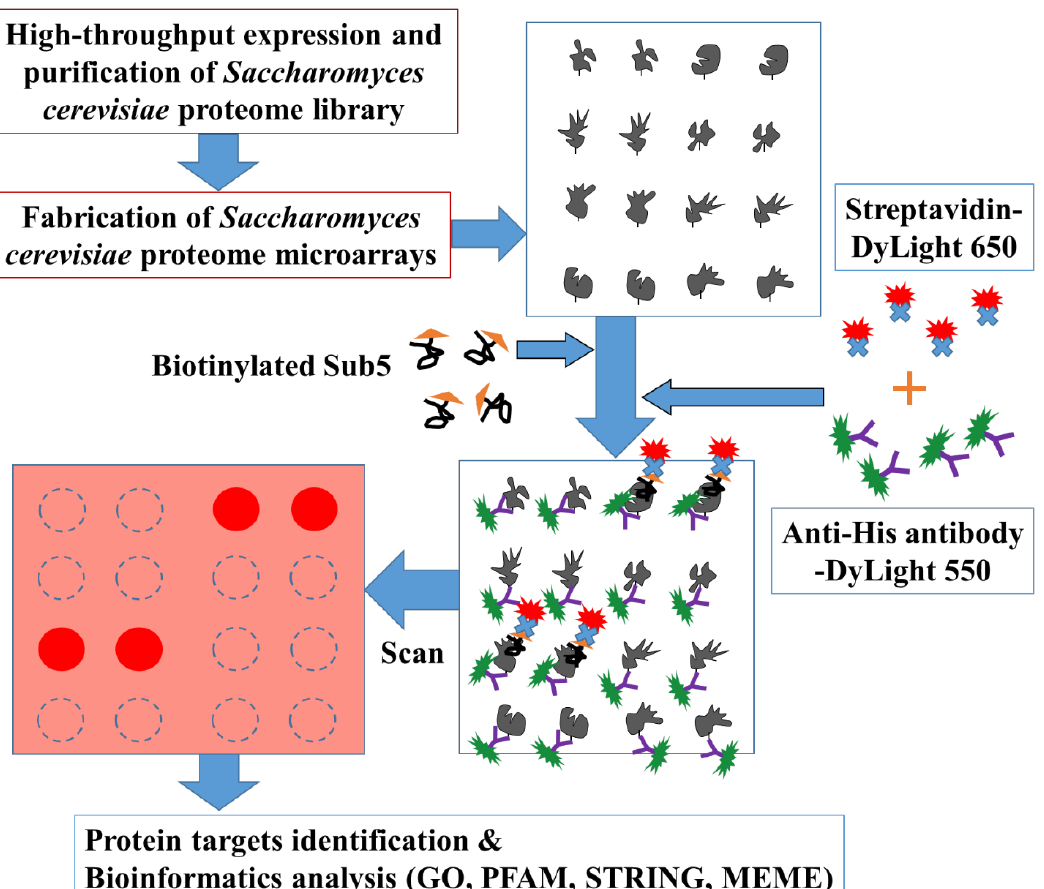
Figure 1. Schematic diagram for identifying the protein targets of Sub5 using Saccharomyces cerevisiae proteome microarrays. To find the targets, biotinylated Sub5 was probed on Saccharomyces cerevisiae proteome microarrays and later probed with streptavidin-DyLight 650 and anti-His antibody-DyLight 550 for the detection of signal of biotinylated Sub5 that interacted with Saccharomyces cerevisiae proteins, and proteins containing His tag to represent the protein amount of each proteins on Saccharomyces cerevisiae proteome microarrays, respectively. The protein targets of Sub5 were identified using several cutoff parameters and the final list of protein targets of Sub5 were analyzed with bioinformatics tools gene ontology (GO), Protein family (PFAM), Search Tool for the Retrieval of Interacting Genes/Proteins (STRING), and Multiple Expression motifs for Motif Elicitation (MEME).